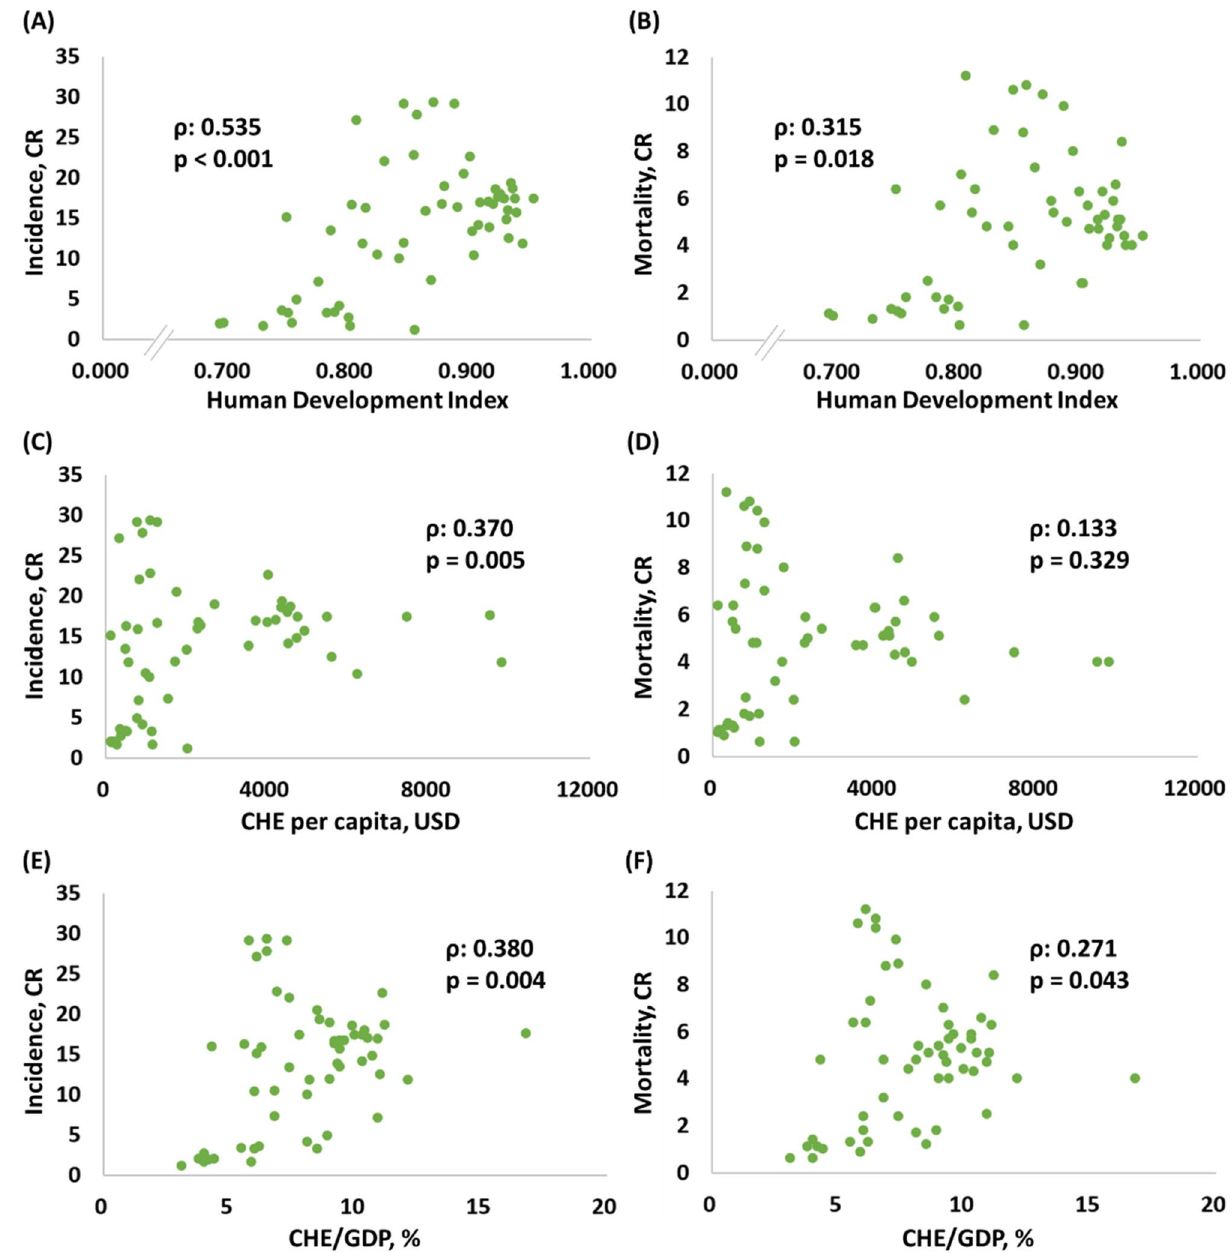
Figure 1. Association between HDI, CHE, and the crude rates of ( A , C , E ) incidence and ( B , D , F ) mortality in